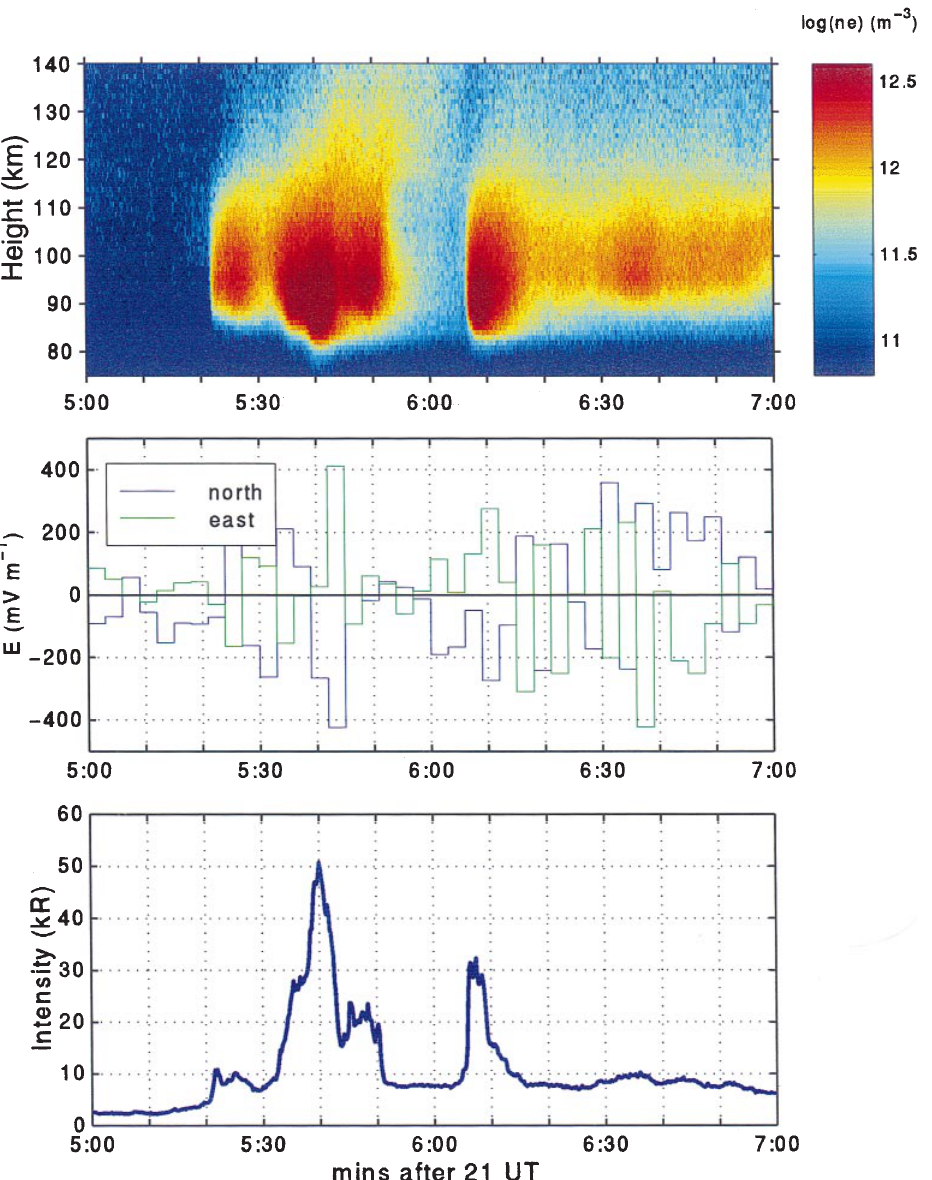
Fig. 1. Top panel: electron den- sity profiles at 0.2-s resolution showing both passages of the arc system through the field-aligned radar. Middle panel: horizontal electric field components at 3-s resolution measured at 278 km. The largest field at 21:05:42 UT is in SE direction. Bottom panel: intensity of 427.8-nm emission rate in field